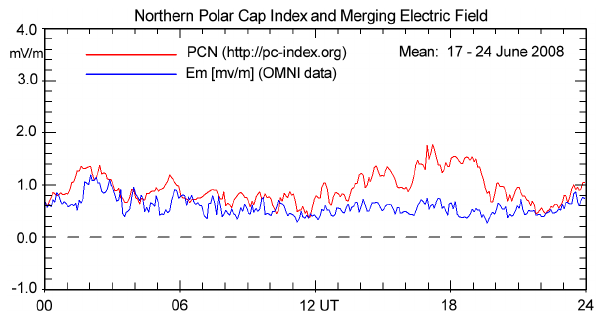
Figure 12. Display of 8-day averages of PCN-IAGA indices (red line) and E M -OMNI values (blue line) for the quiet interval 17–24 June